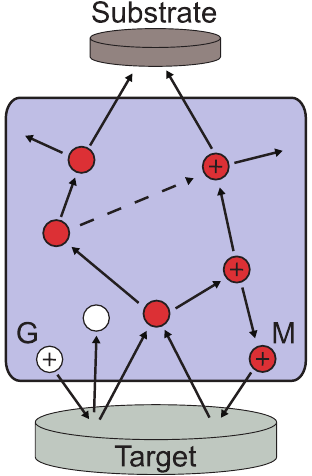
Fig. 2 Schematic of the sputtering process based on the target material pathway model by Christie (Christie, 2005). The letters G and M stand for gas and metal, respec- tively. Adapted from Lundin (Lundin, The HiPIMS process,